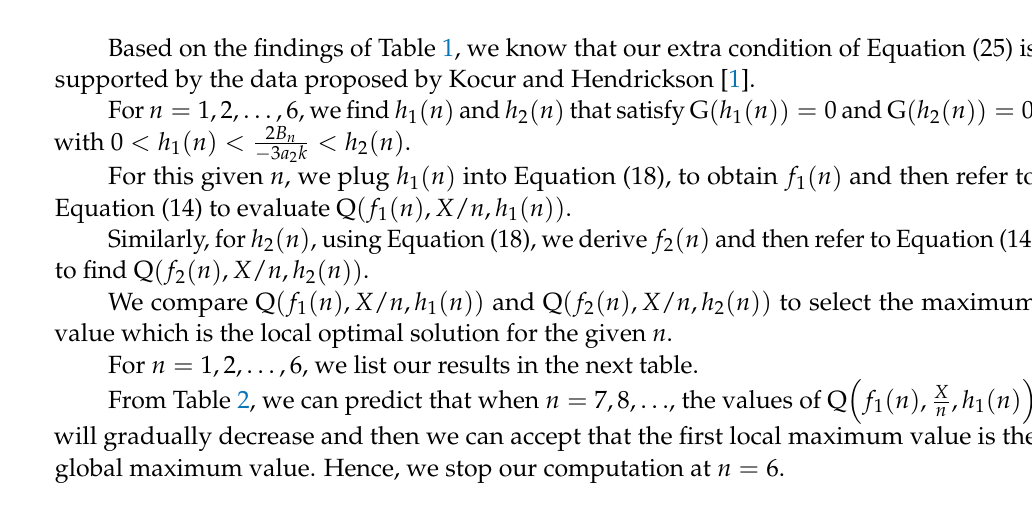
Table 2. Our results for n = 1,2, . . . ,6.